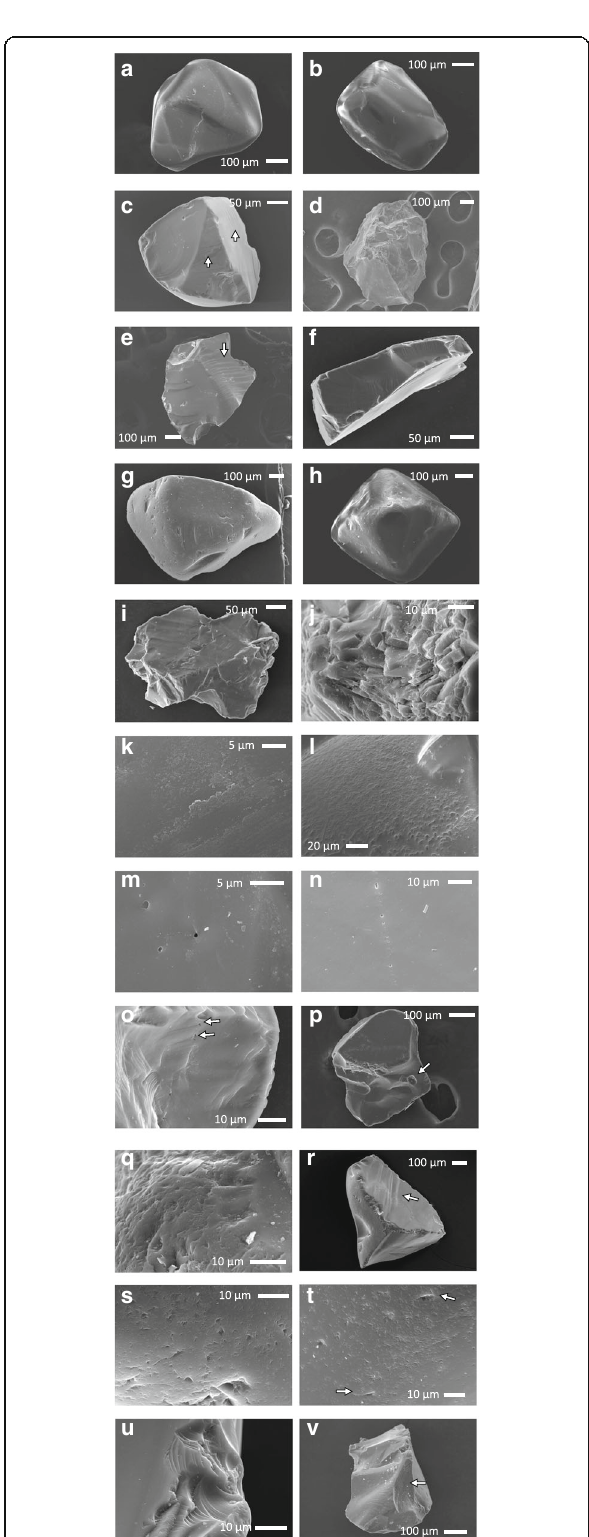
Area IV, Shizuoka The median grain diameter of IV-1 was Φ 1.3 (Table 2). As in area I, colored and magnetic mineral groups were common (47%) in area IV (Fig. 2). The grains exhibited rounded outlines (Table 2). Medium conchoidal fractures and v-shaped percussion cracks were abundant on the grain surfaces (80%), whereas features related to chemical reactions were sparse. Small holes on the grain surfaces were also rare (Table 2).